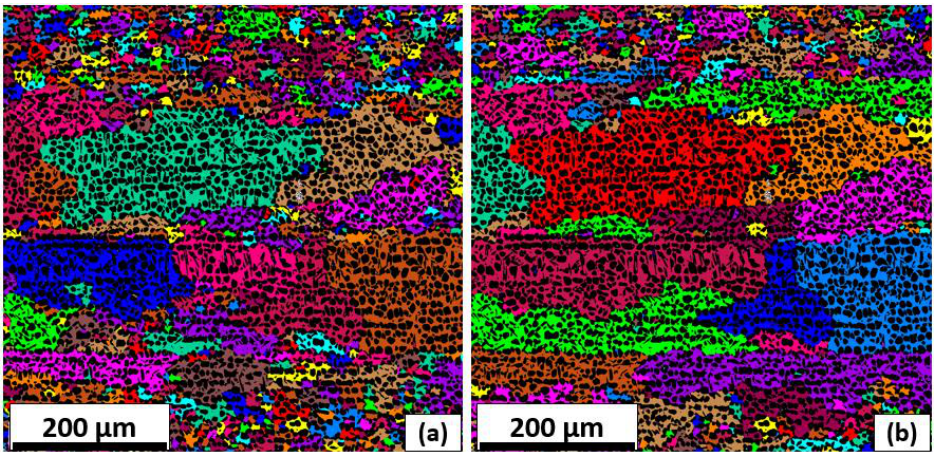
Figure 9. Ferrite grain maps with minimum misorientations of ( a ) 5° and ( b ) 15° of the equiaxed microstructure.